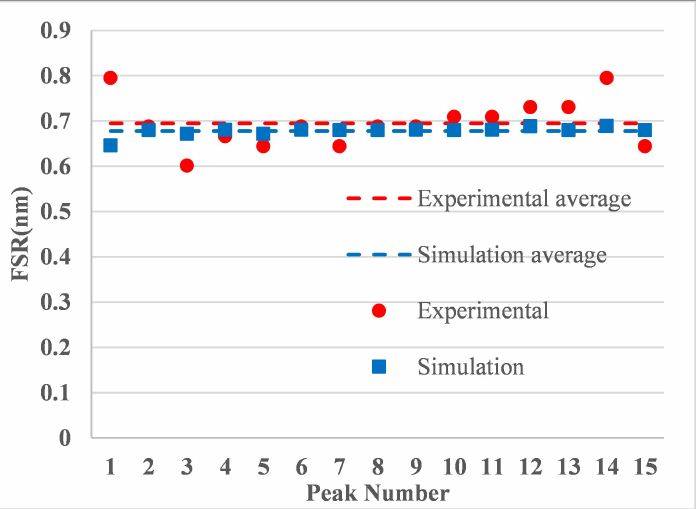
Figure 15. Comparison of the experimental and simulated FSR for a 2D chirped fiber